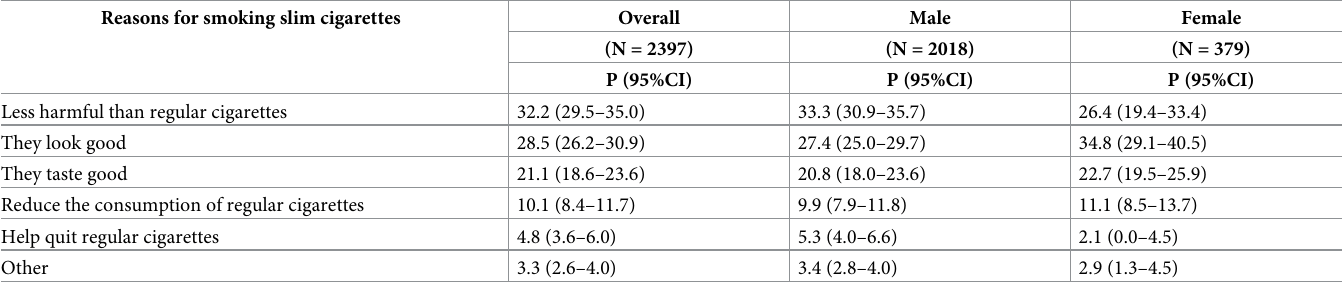
Table 4. Chief reason to smoke slim cigarettes.